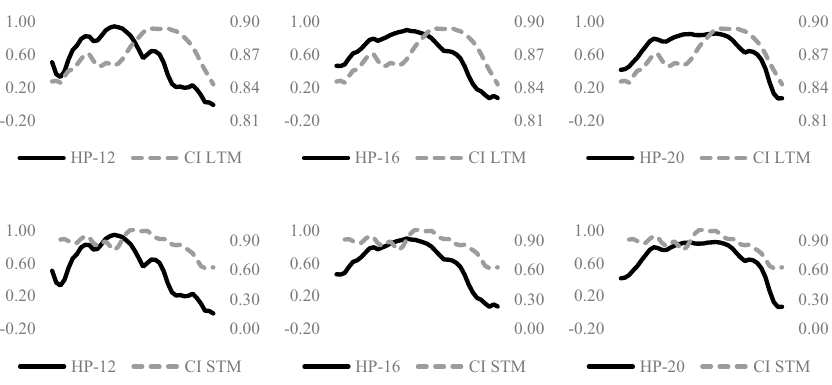
Fig. 1 BCS and IT credibility series in levels, 2006–2015. Source : Own